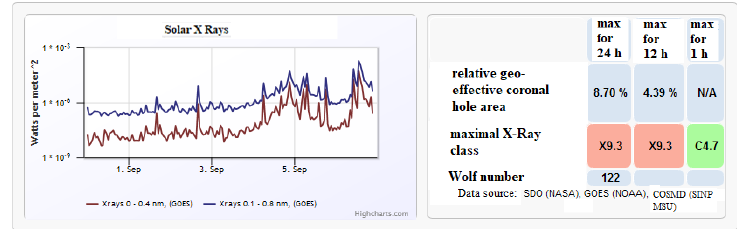
Fig. 5. Presentation of solar activity data on COSMD website for September 06,